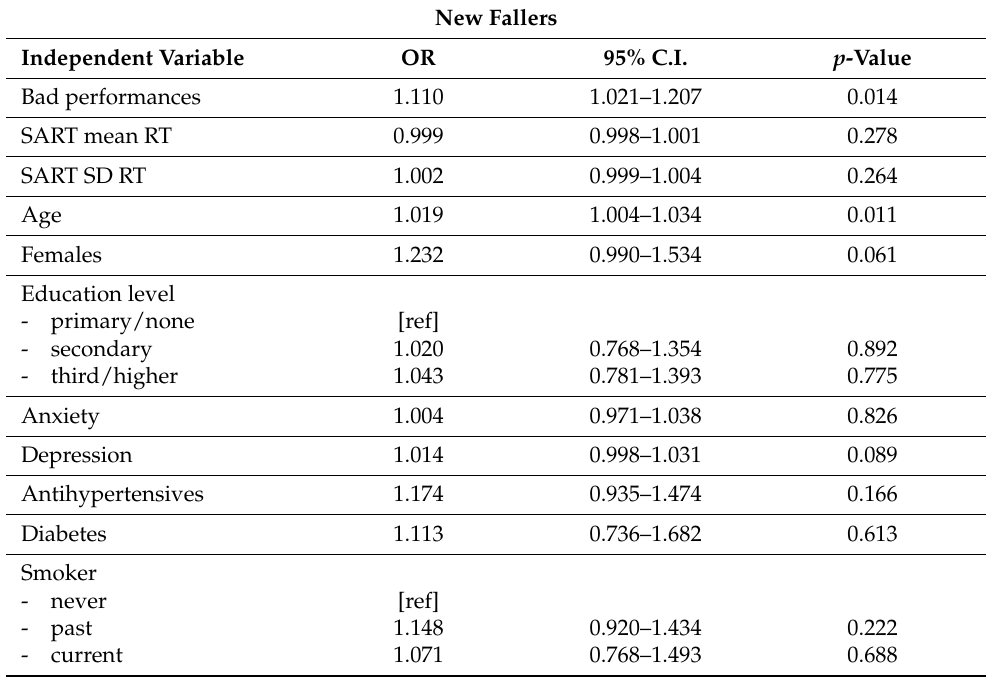
Table A5. Results for the fully adjusted per covariates binary logistic regression model 4a considering bad performances as potential predictor and having New faller as